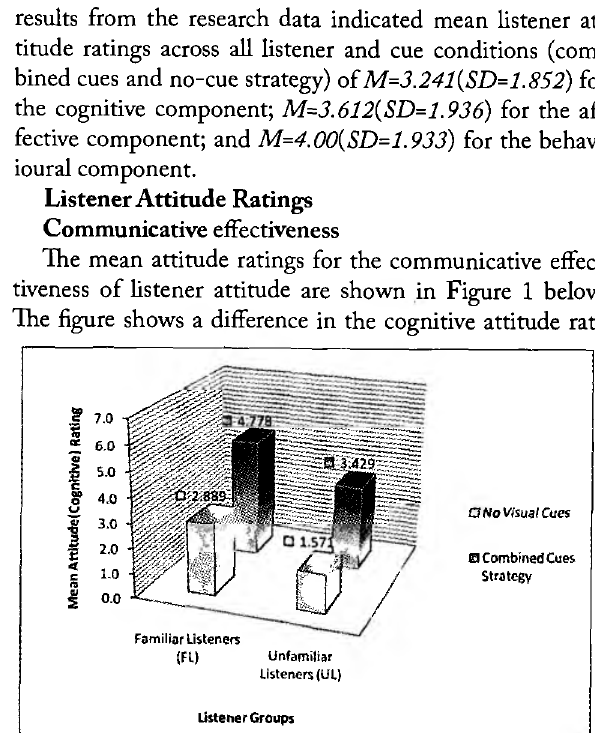
Figure 1. Mean Attitude (cognitive component) ratings for the listener groups (Familiar, Unfamiliar) with Combined ings (mean) for the familiar listener group (Combined cues: M=4.77, SD=1.47;No Cues:M=2.88, SD=1.52) and the un­ familiar listener group (Combined Cues: M=3.42, SD=1.55; No Cues: M -1.57, SD-1.50). The difference exists for both